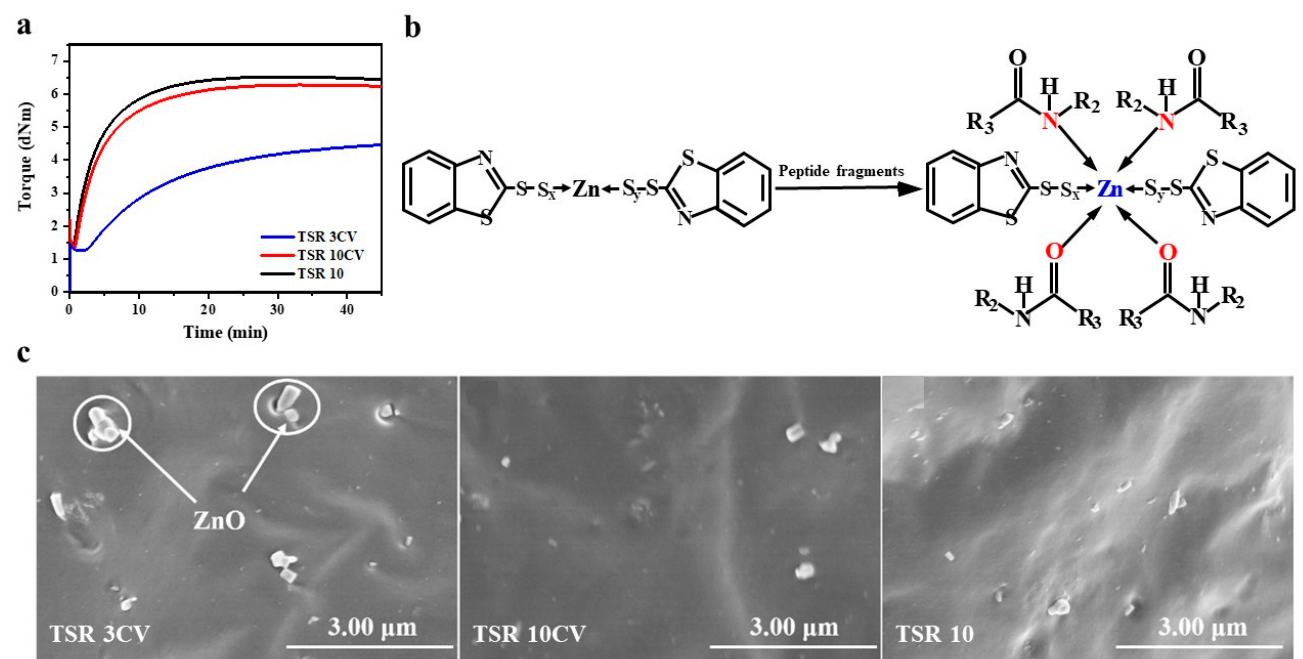
Figure 2. ( a ) Cure curves for TSR 10, TSR 10CV and TSRH 3CV vulcanizates; ( b ) Crosslinking reaction with ZnO [33]; ( c ) SEM images of TSR 3CV, TSR 10CV, TSR 10 (5000 × ). The stress-strain curves of the three vulcanizated samples are compared in Figure 3.